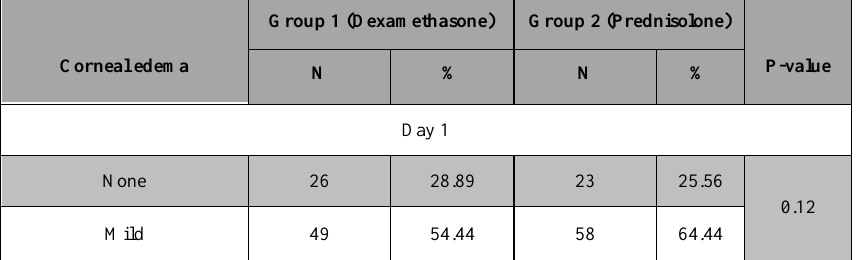
Table 4. Corneal edema comparison among the study